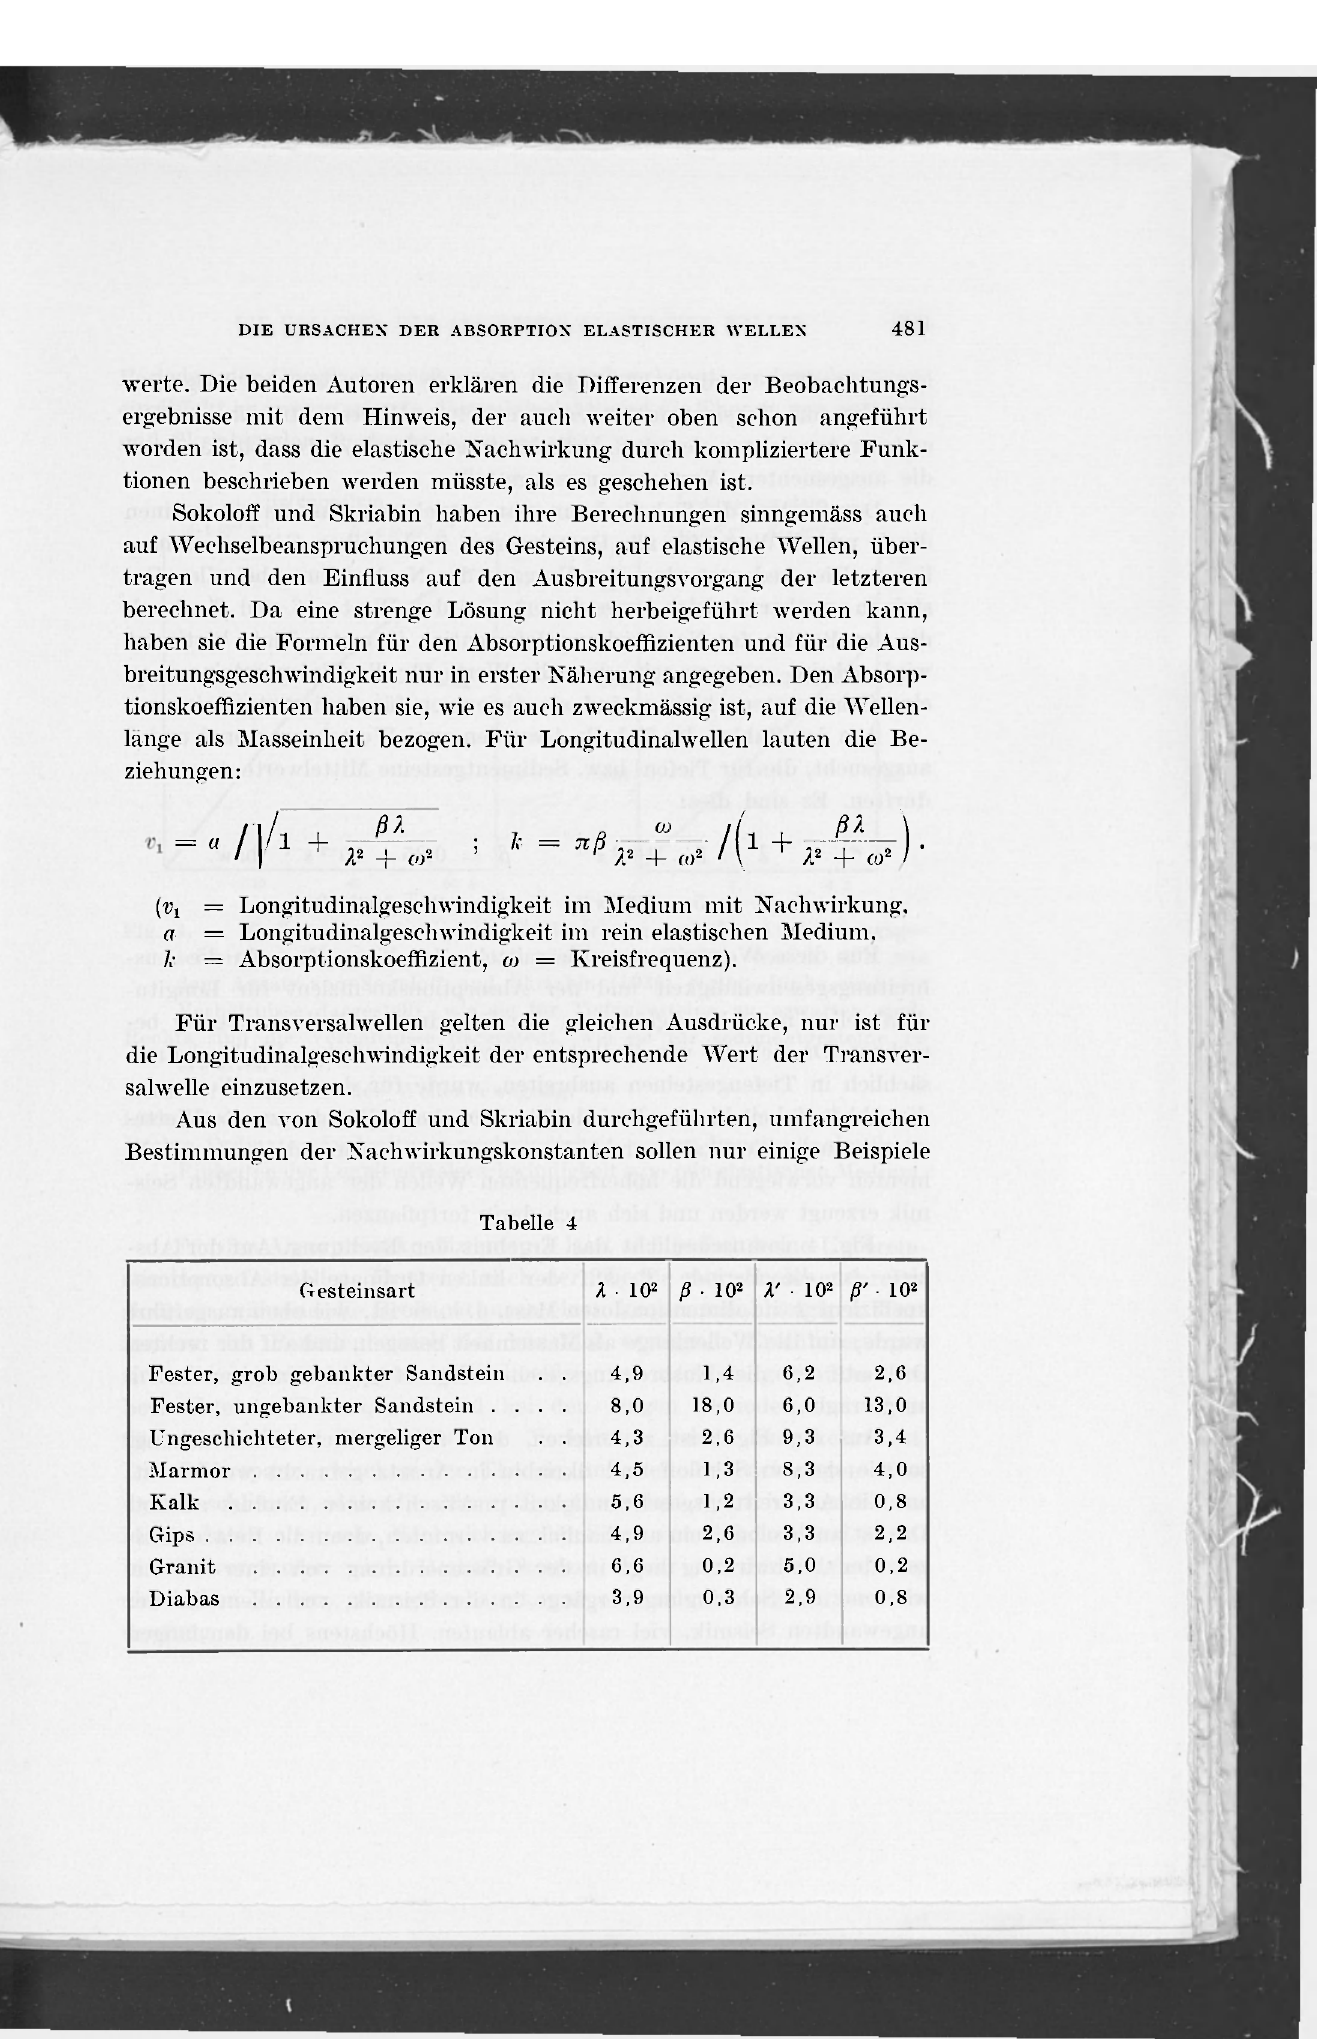
Fiir Transversalwellen gelten die gleichen Ausdrùcke, nur ist fiir die Longitudinalgeschwindigkeit der entsprechende Wert der Transver- salwelle